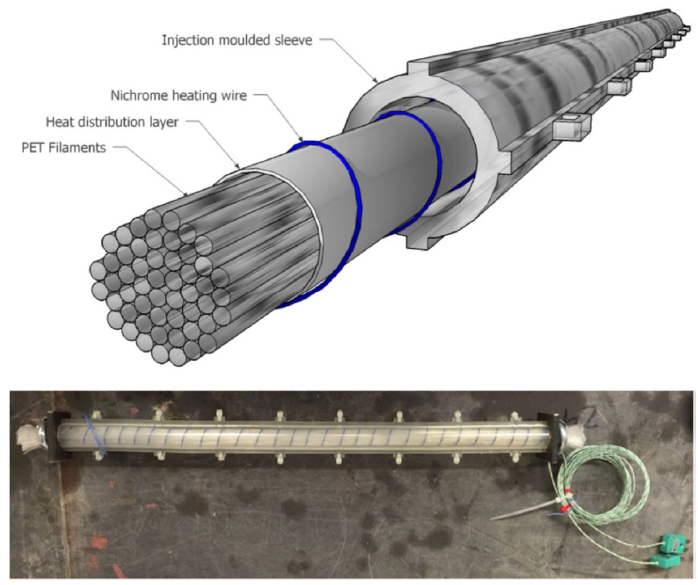
Figure 4. SMP tendon construction, adapted from [42].